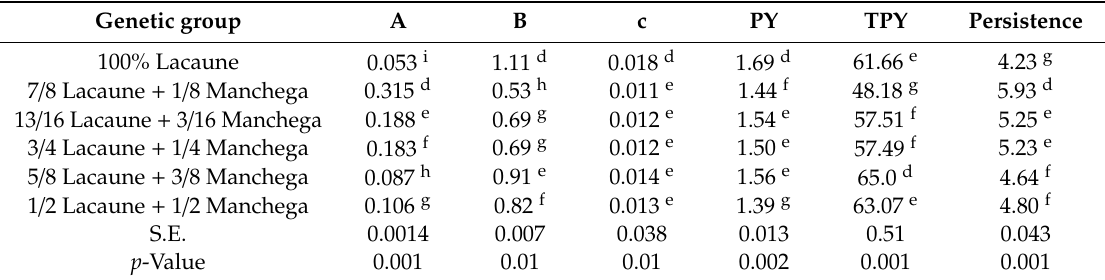
Table 4. Mean parameter estimates of Wood gamma model and characteristics of lactation curves according to the genetic group (Lacaune and their crosses at different degrees with Machega dairy sheep). Genetic group A B PY